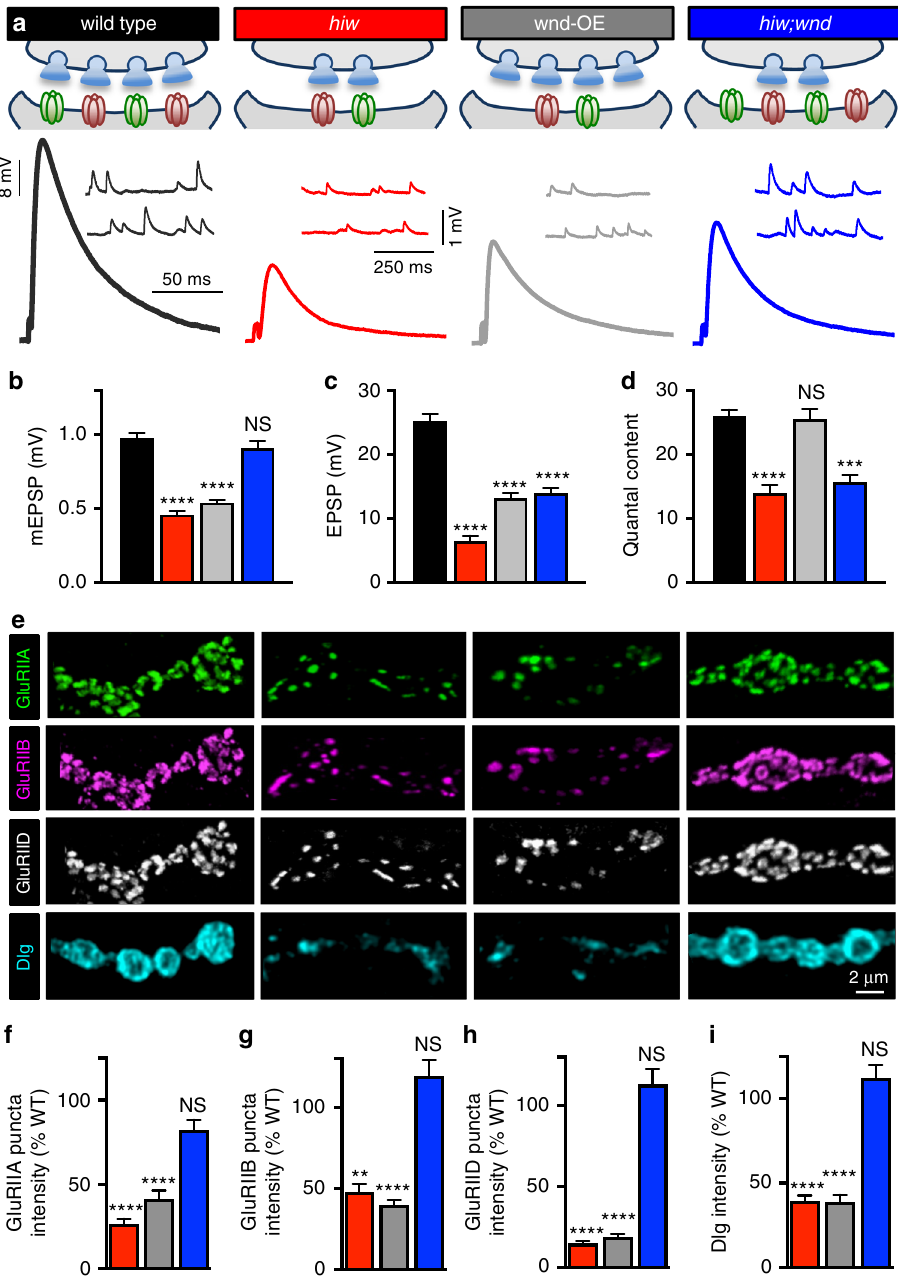
Fig. 1 Postsynaptic reduction in sensitivity to neurotransmitter and GluR remodeling in response to presynaptic Wnd signaling. a Schematic of genetic manipulations to the Drosophila NMJ that activate or silence presynaptic Wnd signaling. Wild-type synapses ( w 1118 ) serve as the control condition. highwire mutants ( hiw : hiw Δ N ) show reductions in postsynaptic sensitivity and presynaptic neurotransmitter release. Neuronal overexpression of Wnd (wnd-OE: c380-Gal4/ + ; UAS-wnd/ + ) results in a similar reduction in postsynaptic sensitivity but normal presynaptic neurotransmitter release (compared to wild type and driver only control: c380-Gal4/ + ; see Supplementary Table 1). Switching off Wnd signaling in hiw mutants ( hiw;wnd: hiw Δ N ;wnd 3 /wnd Df ) suppresses the reduced postsynaptic sensitivity but fails to suppress the reduced presynaptic release. Inset: Representative mEPSP and EPSP electrophysiological traces of third-instar larval NMJs in the indicated genotypes. Quanti fi cation of mEPSP amplitude ( b ), EPSP amplitude ( c ), and quantal content ( d ) in the indicated genotypes. Note that while the reduced mEPSP amplitude observed in wnd-OE and hiw mutants is suppressed in hiw;wnd double mutants, EPSP amplitude and quantal content fails to be restored in this genotype, suggesting a Wnd-independent role for Hiw in regulating presynaptic release but a Wnd-dependent role in modulating postsynaptic sensitivity to neurotransmitter. e Representative images of muscle 4 NMJs immunostained with antibodies against three postsynaptic glutamate receptor subunits (GluRIIA: green; GluRIIB: magenta; GluRIID: white) or Disc-Large (Dlg: blue). Quanti fi cation of individual GluRIIA ( f ), GluRIIB ( g ), and GluRIID ( h ) puncta sum intensity (total fl uorescence of each individual GluR puncta) and i average intensity of Dlg staining encapsulating each bouton normalized to wild-type reveals reduced levels of this postsynaptic scaffold and receptors induced by presynaptic Wnd signaling in hiw mutants and wnd-OE. This response is suppressed in hiw;wnd double mutants. Error bars indicate ± SEM. One- way analysis of variance (ANOVA) test was performed, followed by a Tukey ’ s multiple-comparison test. ** p 0.01; *** p = 0.001; **** p = 0.0001, NS not signi fi cant, p >